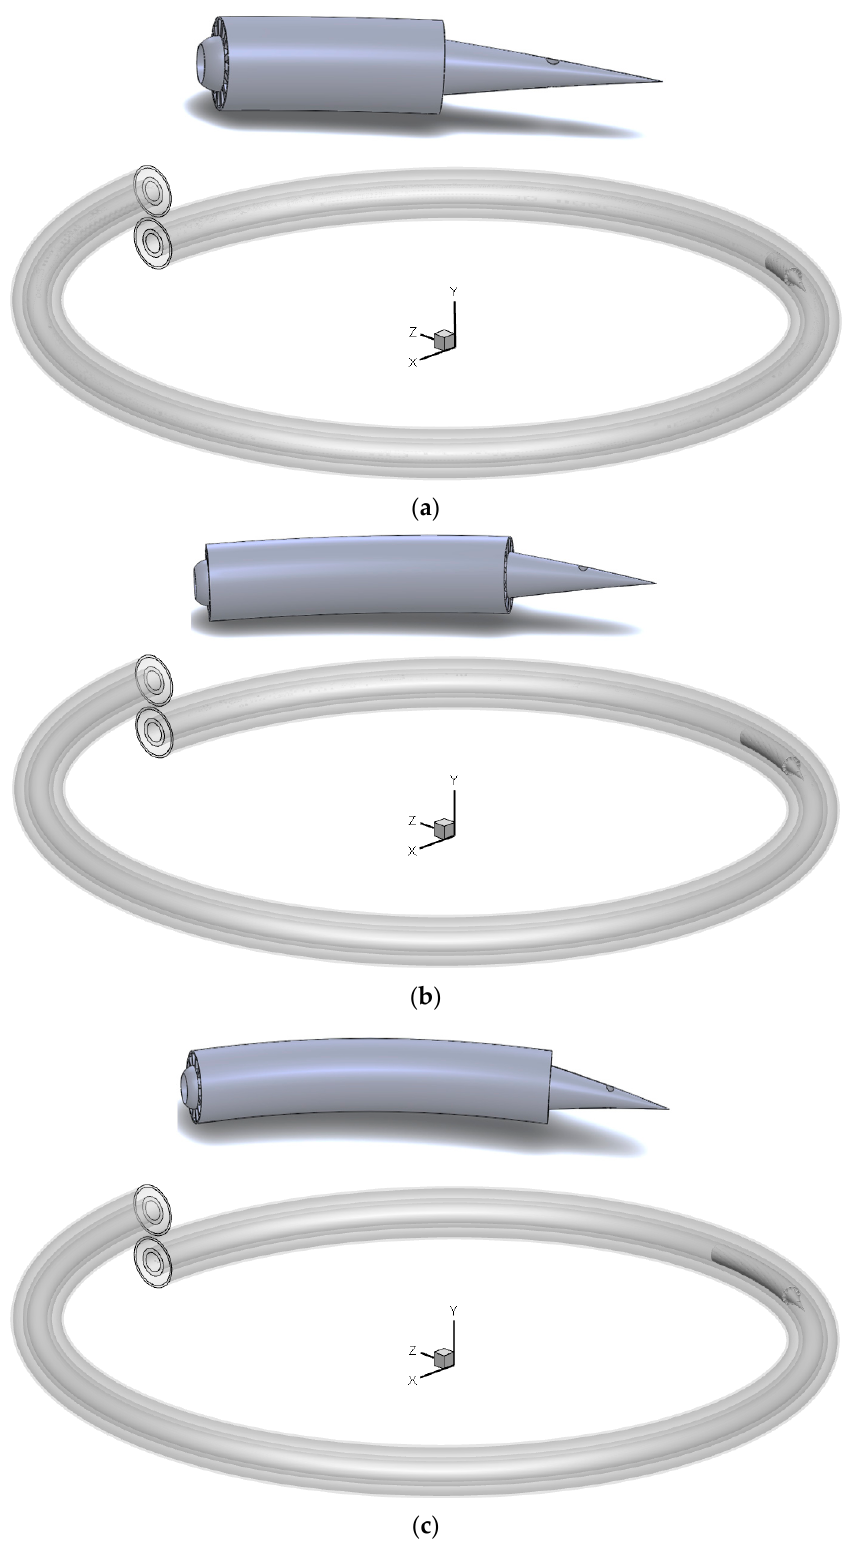
Figure 3. The configuration of the swirl generators with various lengths at n = 12, θ = 180 degrees, and S = 0.3 π mm; ( a ) L 1 = 100 mm, ( b ) L 1 = 200 mm, and ( c ) L 1 = 300 mm.